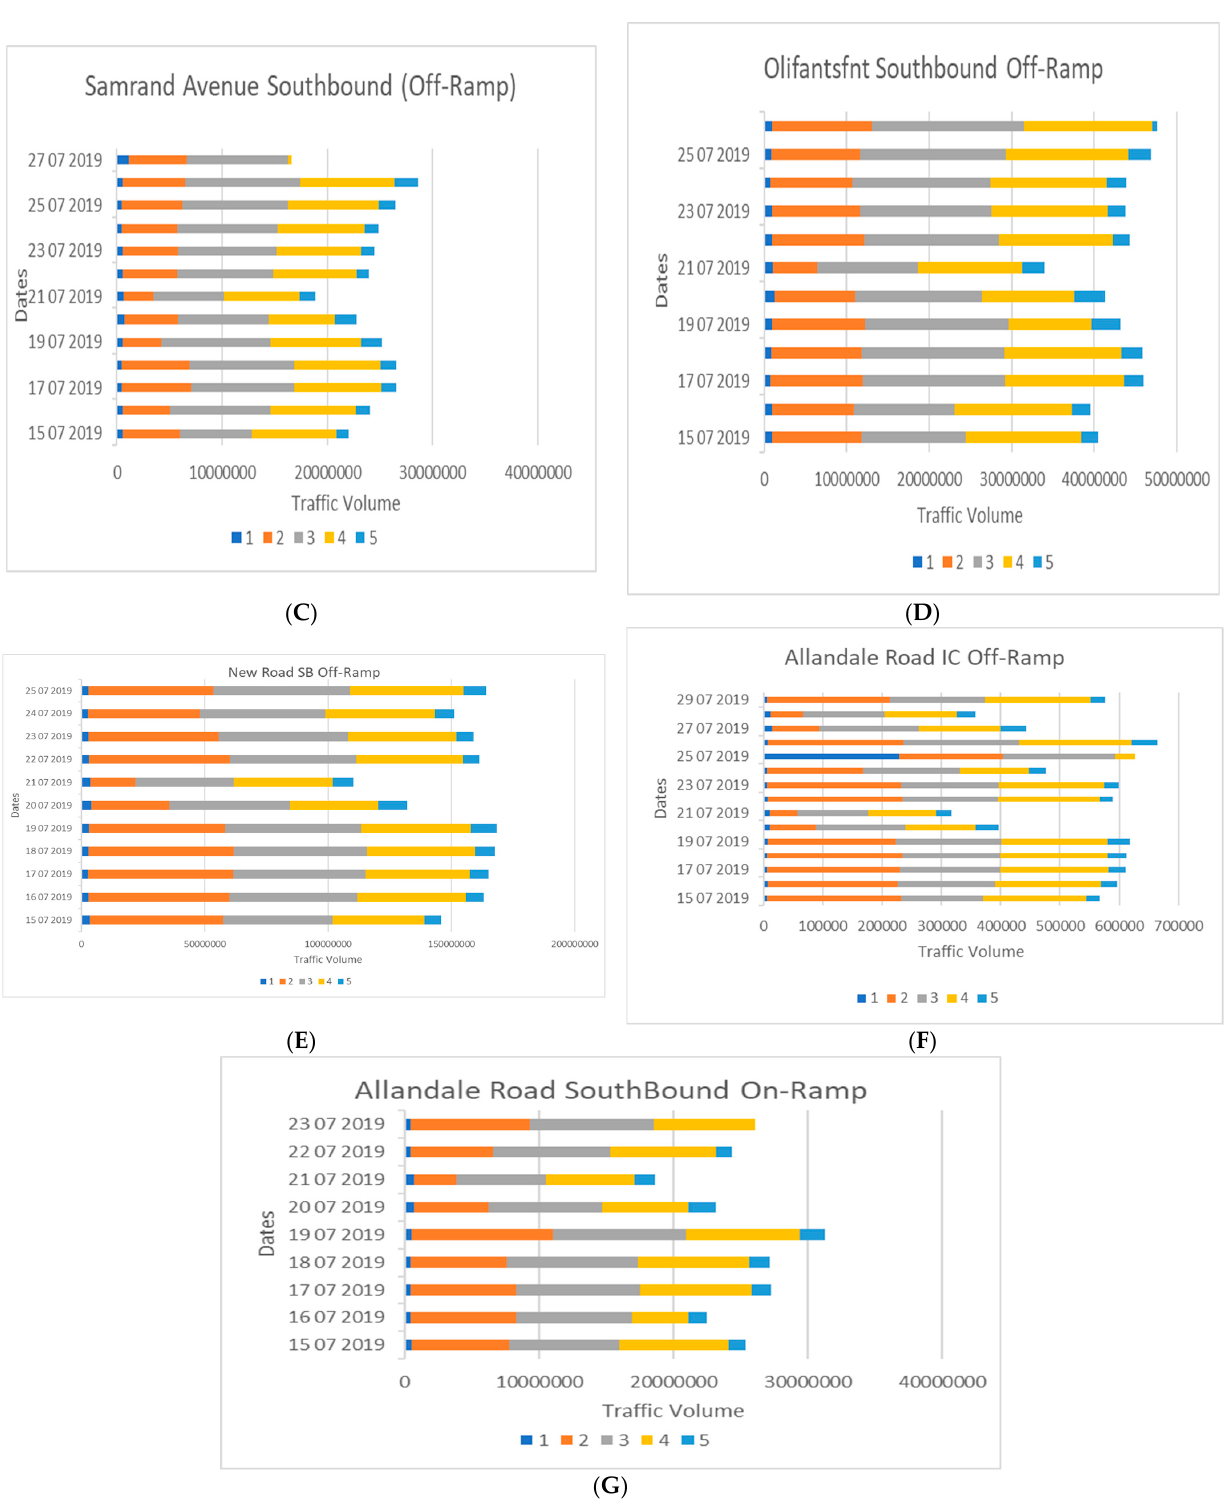
Figure A1. Note: 1: 00:00:00–04:59:59 (Off-peak), 2: 05:00:00–09:59:59 (On-peak), 3: 10:00:00–14:59:59 (On-peak), 4: 15:00:00–19:59:59 (On-peak), 5: 20:00:00–23:59:59 (Off-peak). Furthermore, it is important to note that for all the figures, the unit of traffic volume is vehicles/day or vehicles/h. ( A ) Brakfontein 1C N1 SB; ( B ) Old Johannesburg Road SB (off-ramp); ( C ) Samrand Avenue SB (off-ramp); ( D ) Olifantsfnt SouthBound off-ramp; ( E ) New road SB off-ramp; ( F ) Allandale road IC off-ramp; ( G ) Allandale road SouthBound on-ramp.